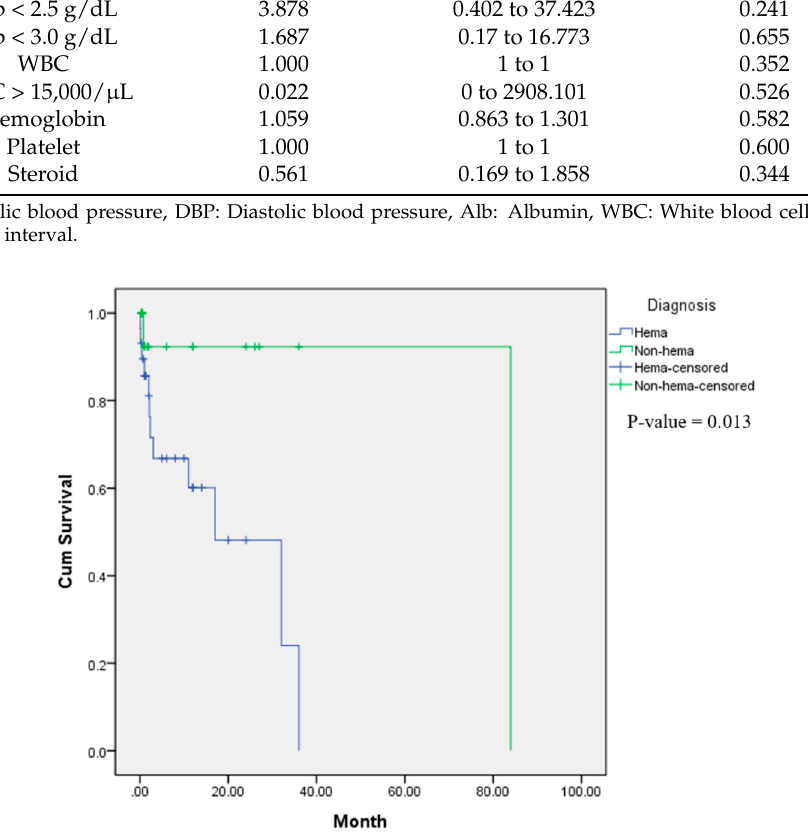
Figure 2. Kaplan-Meier analysis showing there was a decreased survival rate in systemic capillary syndrome patients with hematologic malignancies ( p = leak syndrome patients with hematologic malignancies ( p = 0.013).